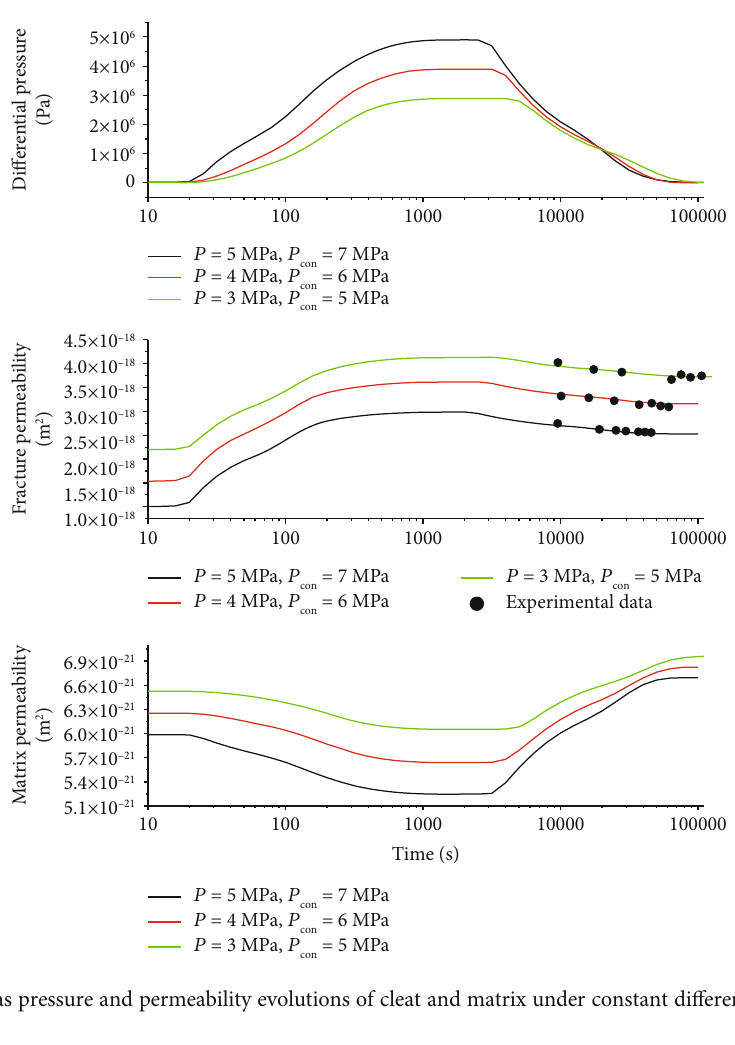
Figure 12: Modeling gas pressure and permeability evolutions of cleat and matrix under constant di ff erence pressure conditions.